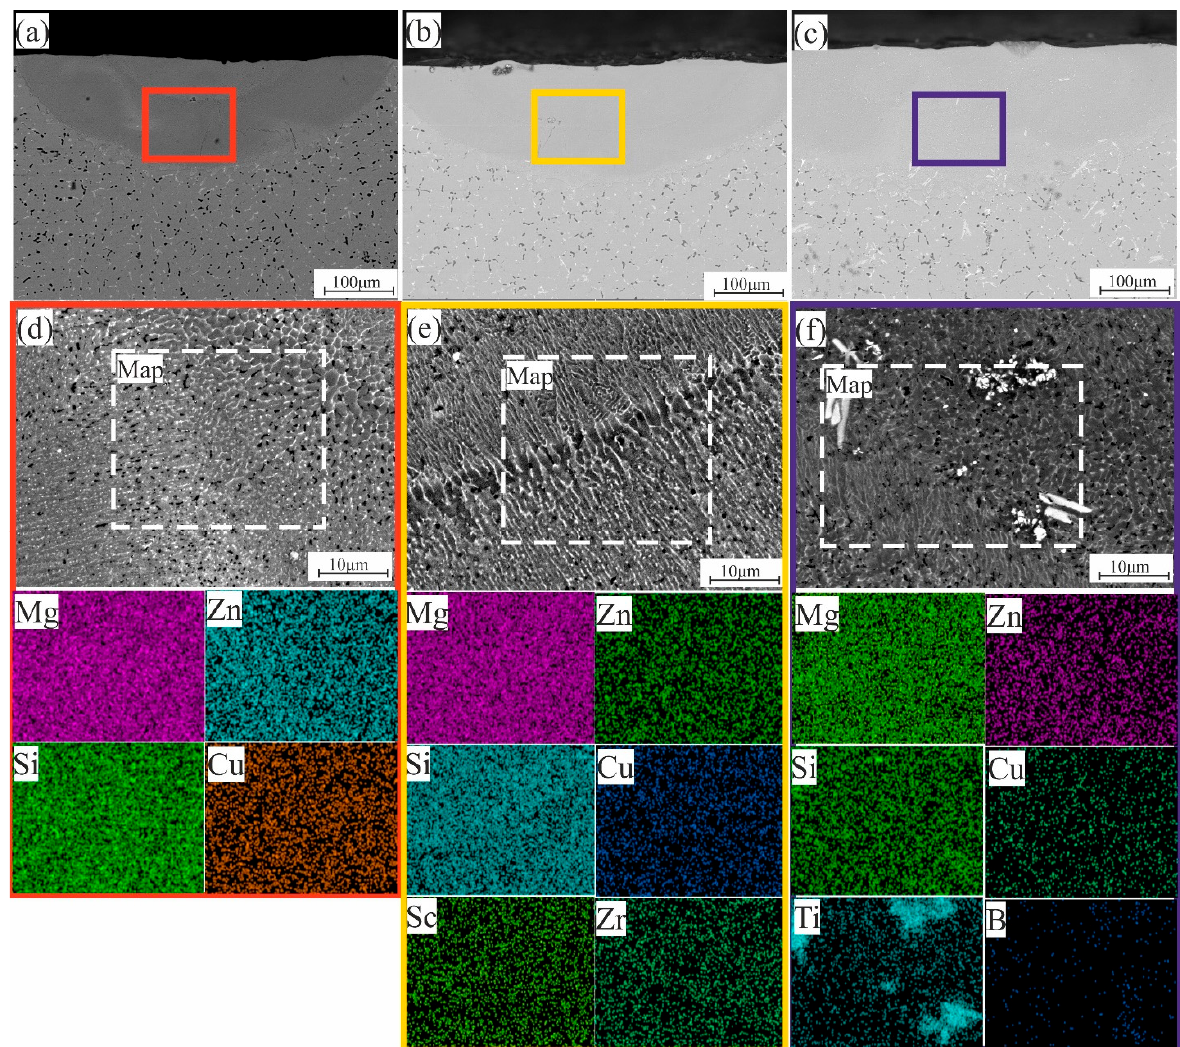
Figure 8. SEM micrographs and EDS maps analysis of the LMZ of the homogenized samples; ( a , d ) 7075-4%Si, ( b , e ) 7075-4%Si + ScZr, and ( c , f ) 7075-4%Si + TiB.